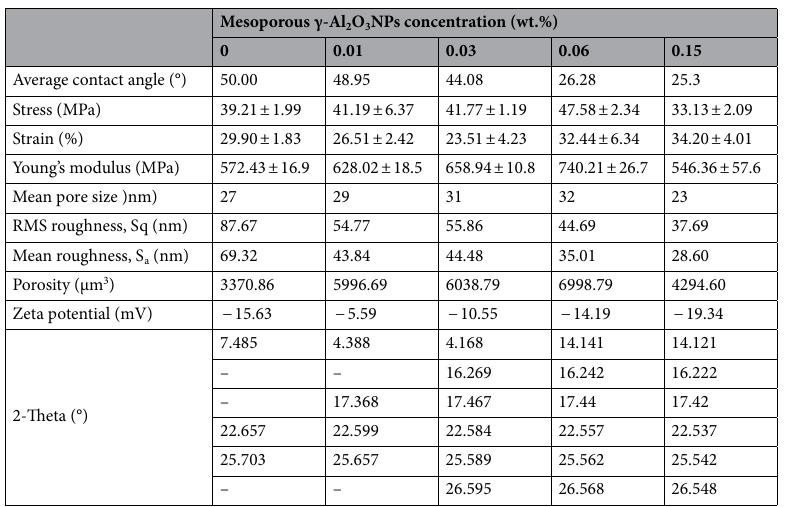
Figure 8. ( a ) Water contact angle and ( b ) stress–strain curves of TFC membrane, and TFN-Al 2 O 3 membranes with varied fractions of mesoporous γ-Al 2 O 3 NPs. Mesoporous γ-Al 2 O 3 NPs concentration